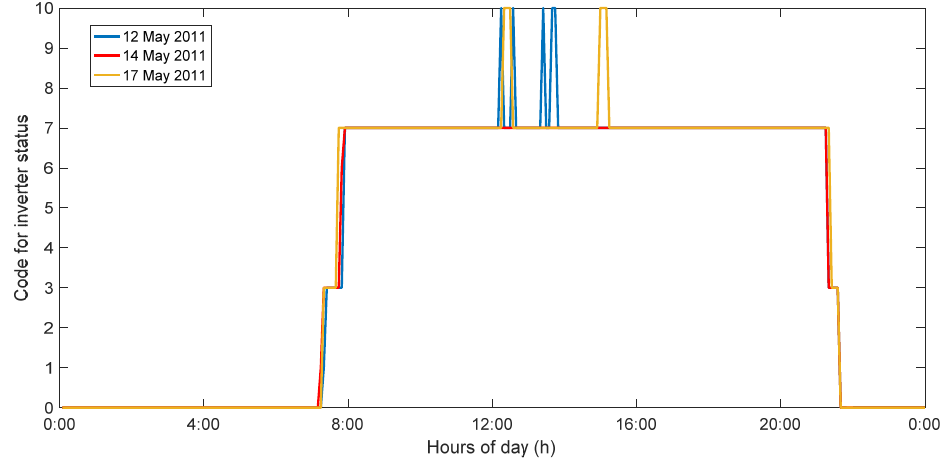
Figure 22. Daily profiles of inverter state obtained during 12, 14 and 17 May 2011.